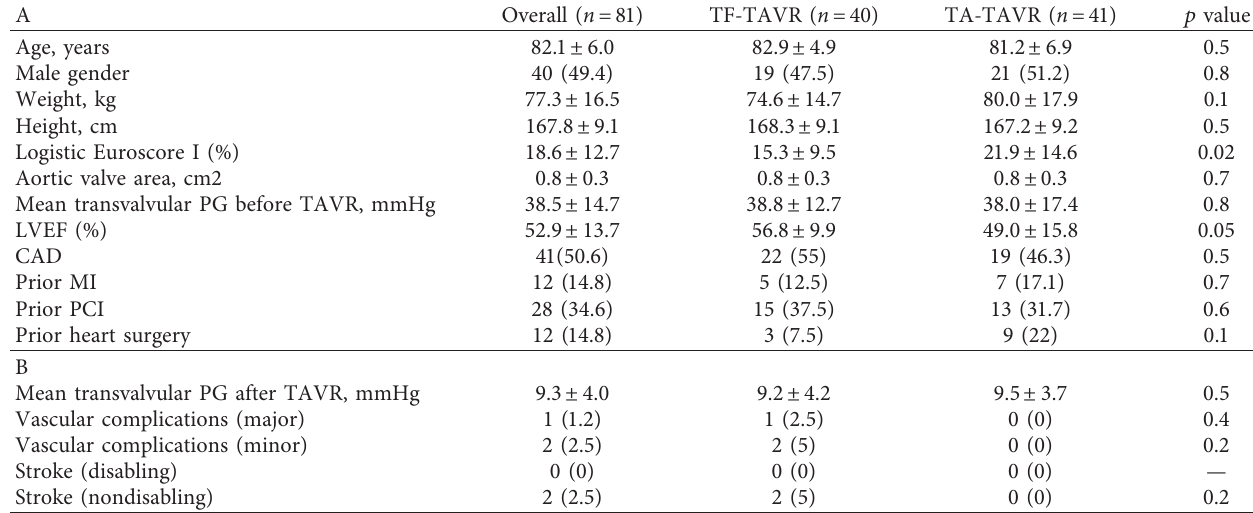
Table 1: Baseline and postprocedural characteristics.